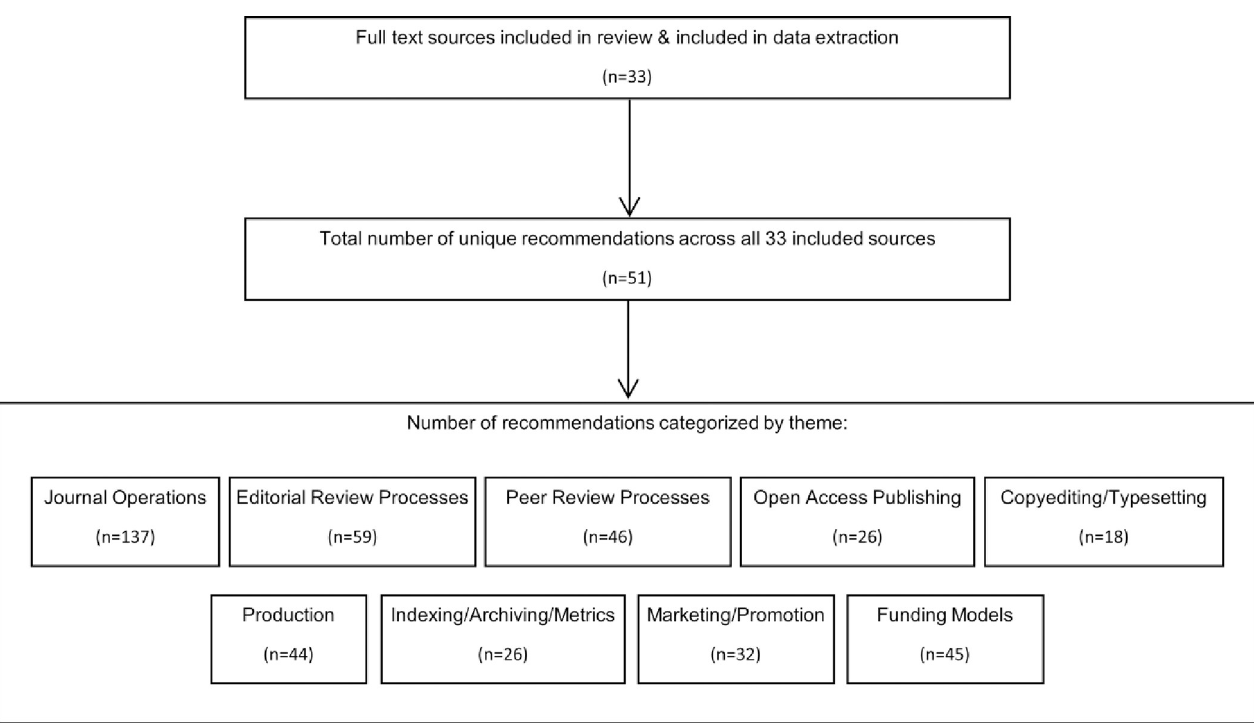
Fig 2. Flow diagram summarizing the number of recommendations extracted from all included sources, the number of unique recommendations found, and the categorization of recommendations by theme. * The total number of unique recommendations across all 33 sources does not equal to the total number of individual recommendations in the bottom box as recommendations can overlap across categories and individual recommendations regarding the same idea/statement were grouped to produce a count of unique recommendations.